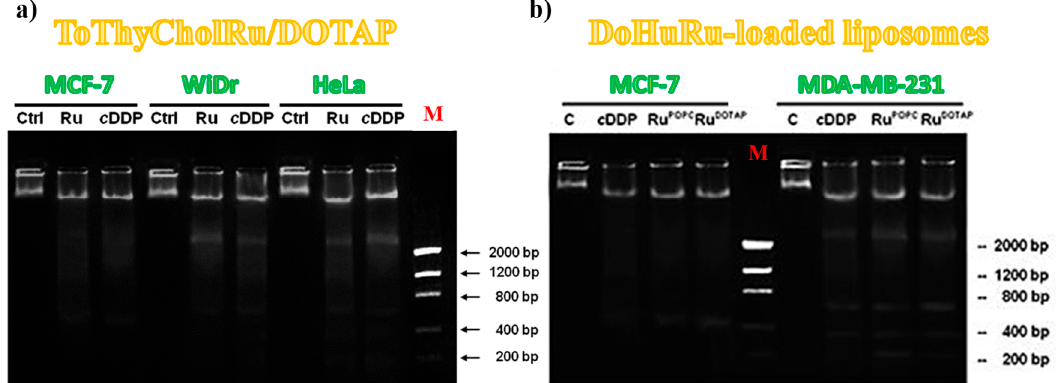
Figure 11. 1.5% agarose gels representing the DNA fragmentation assay on MCF-7, WiDr and HeLa cells, treated or not (Ctrl) for 48 h with IC 50 doses of ToThyCholRu–DOTAP liposomes (indicated as Ru) ( a ) and MCF-7 and MDA-MB-321 cells treated or not (C) with IC 50 concentrations of DoHuRu / POPC (Ru POPC ) and DoHuRu / DOTAP (Ru DOTAP ) for 48 h ( b ). In both experiments, the selected cell lines were also treated with IC 50 conc. of cisplatin (cDDP) used as a control. Lane M corresponds to the molecular weight markers. Figures are adapted from [79] ( a ) and [134] ( b ).